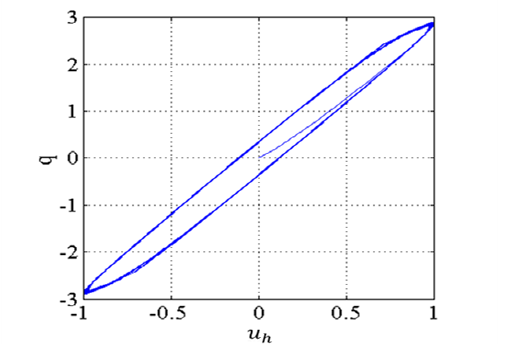
Fig. 4: Simulated hysteresis